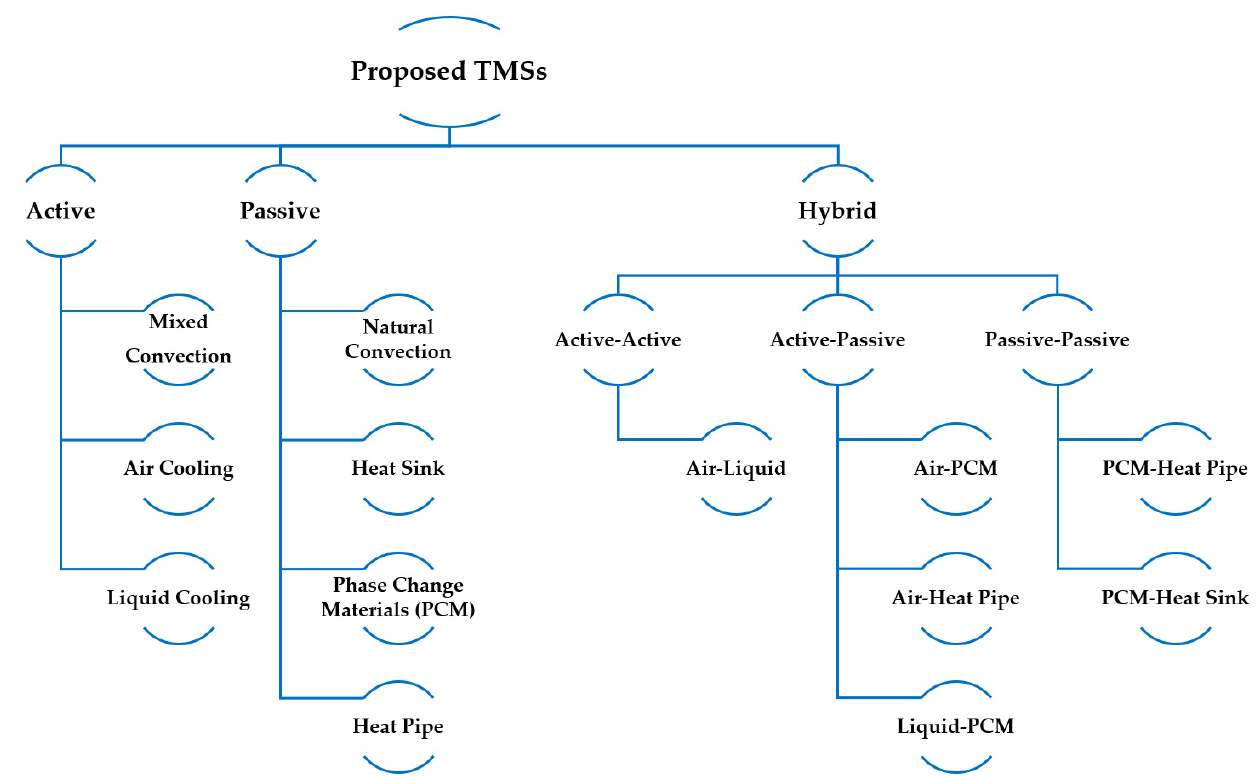
Figure 2. The various types of TMSs addressed in the literature for the high-power LiCs.